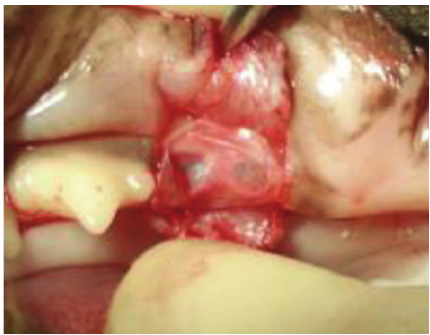
Figure 29: Cellulosic membranes used as dental cavities covering in cats [226].